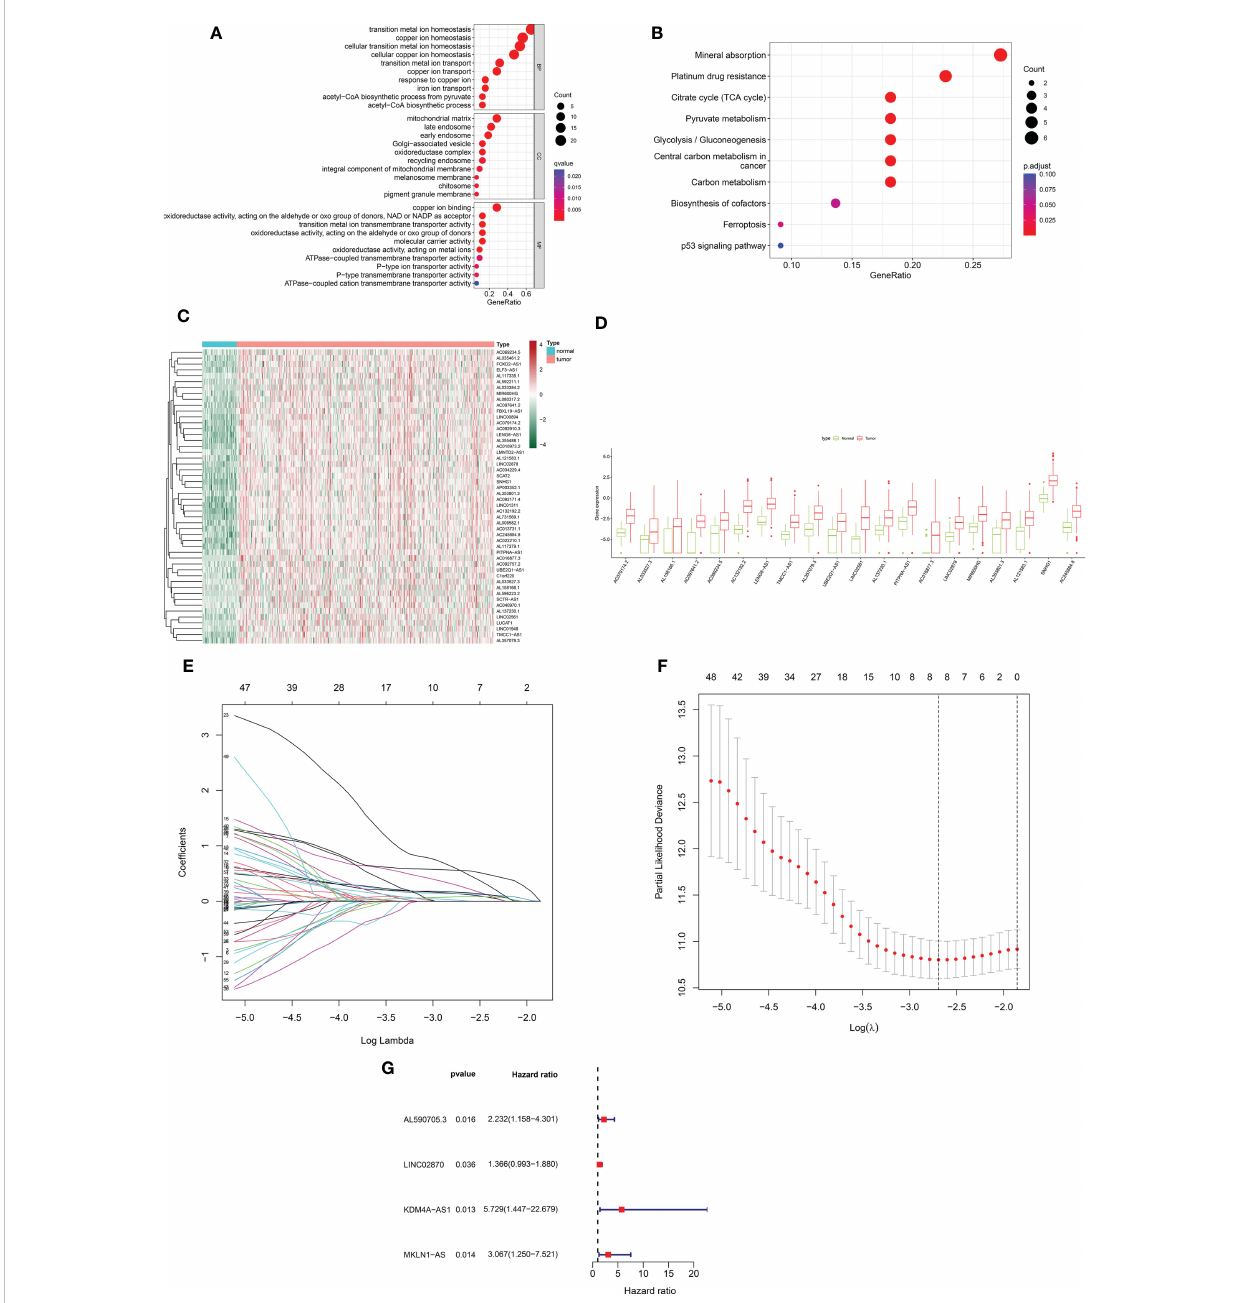
FIGURE 1 Construction of a prognostic risk pro fi le for HCC patients based on cuproptosis-related lncRNAs in a training cohort. (A) GO enrichment analysis of cuproptosis genes. (B) KEGG enrichment analysis of copper death-related genes. (C) Heatmap of 50 cuproptosis-related differentially expressed lncRNAs in tumor and normal samples. (D) Boxplots of 20 cuproptosis-related differentially expressed lncRNAs in tumor and normal samples. (E) Distribution plot of the LASSO coef fi cient. (F) Distribution plot of the partial likelihood deviation of the LASSO regression. Eight variables were retained when the partial likelihood deviation reached the minimum (log lambda = – 2.7). (G) The Forest plot showed 4 lncRNAs identi fi ed by multivariate Cox regression in the training